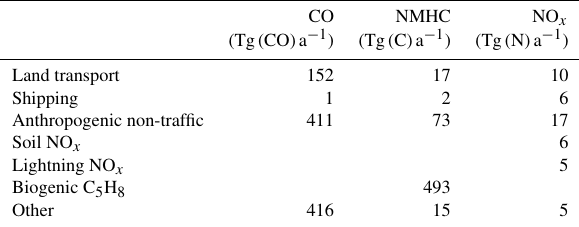
Table 2. Average (2006–2010) annual total emissions of CO (in Tg ( CO ) a − 1 ), NO x (in Tg ( N ) a − 1 ), and NMHC (in amount of carbon) of the most important emission categories. The category “other” contains the emissions of the sectors biomass burning, agri- cultural waste burning, and other biogenic